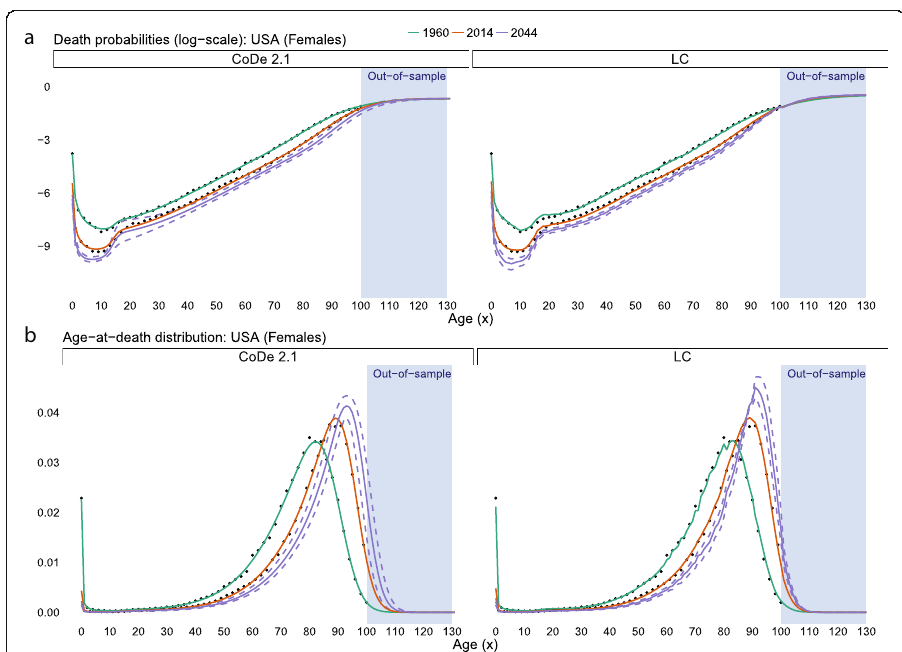
Fig. 6 Estimations and projections of the death probabilities and the age-at-death distribution for American females for the years 1960, 2014, and 2044 and for ages 0 – 130. CoDe 2.1 (left) and LC (right). The dotted lines are observations and the dashed lines are 95% projection intervals. The reference period is 1960 – 2014